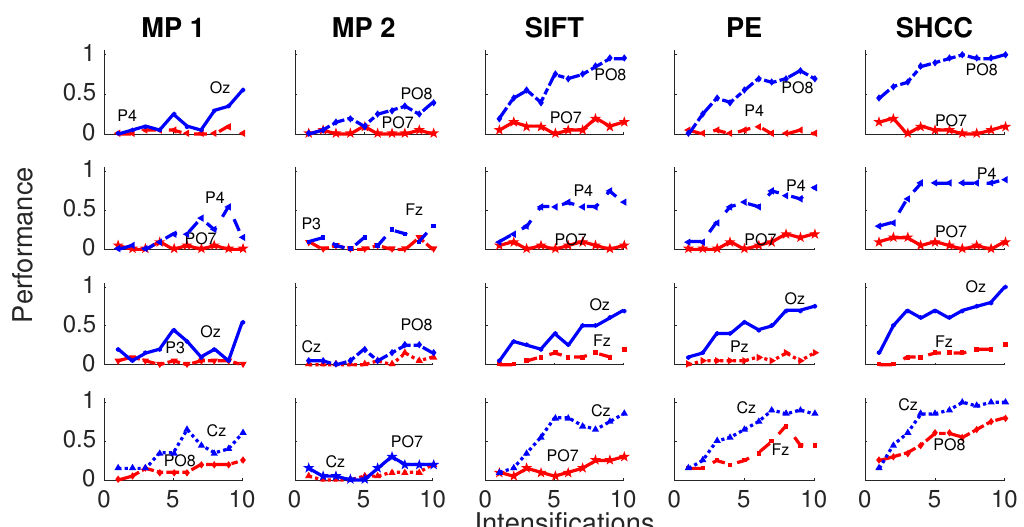
Figure 7. Active Modality—Experiment 1:Speller performance curves obtained for each method for the four subjects that performed the active modality protocol. Y-axis shows performance accuracy while X-axis shows the number of intensification sequences used to calculate the point-to-point signal average. The two curves show the performance for the best and worst performing channel.